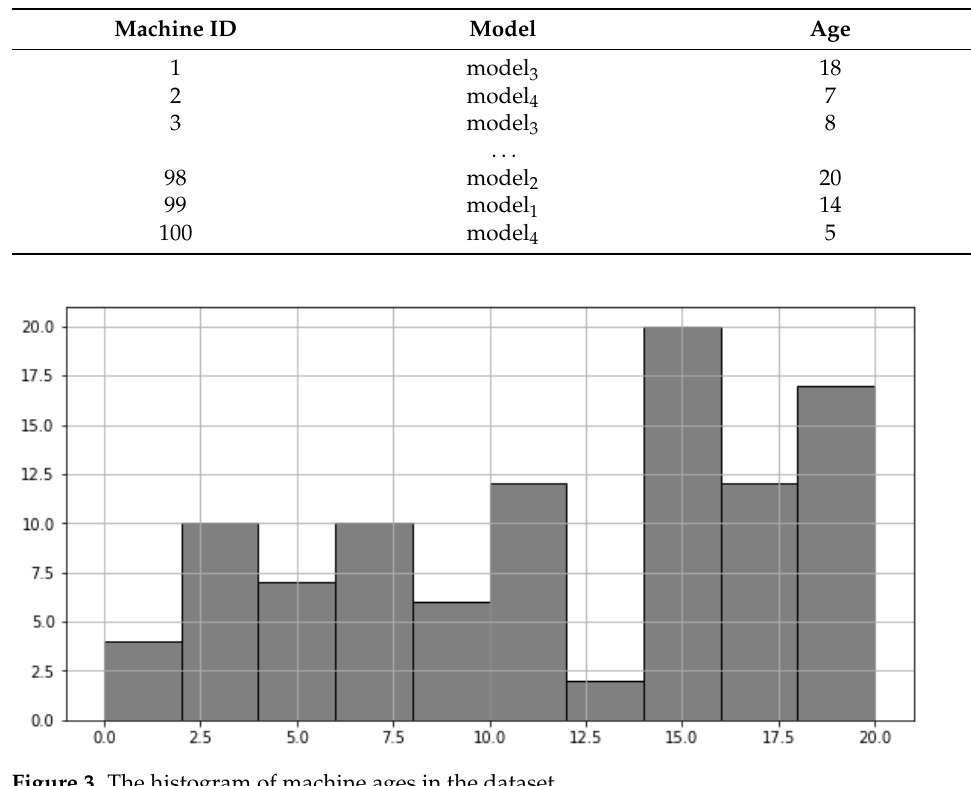
Figure 3. The histogram of machine ages in the